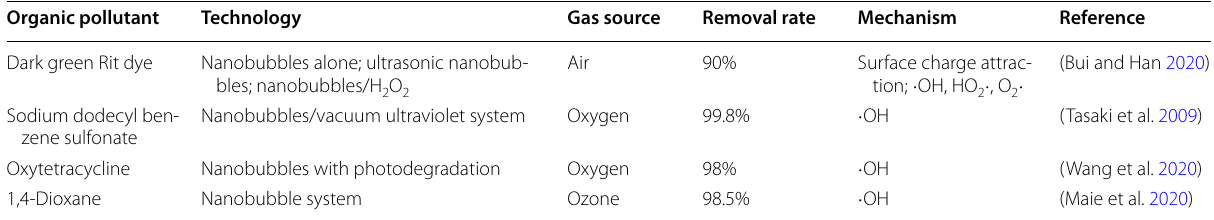
Table 1 Typical researches of removal efficiency of organic pollutants by bulk nanobubble-based advanced oxidation Organic